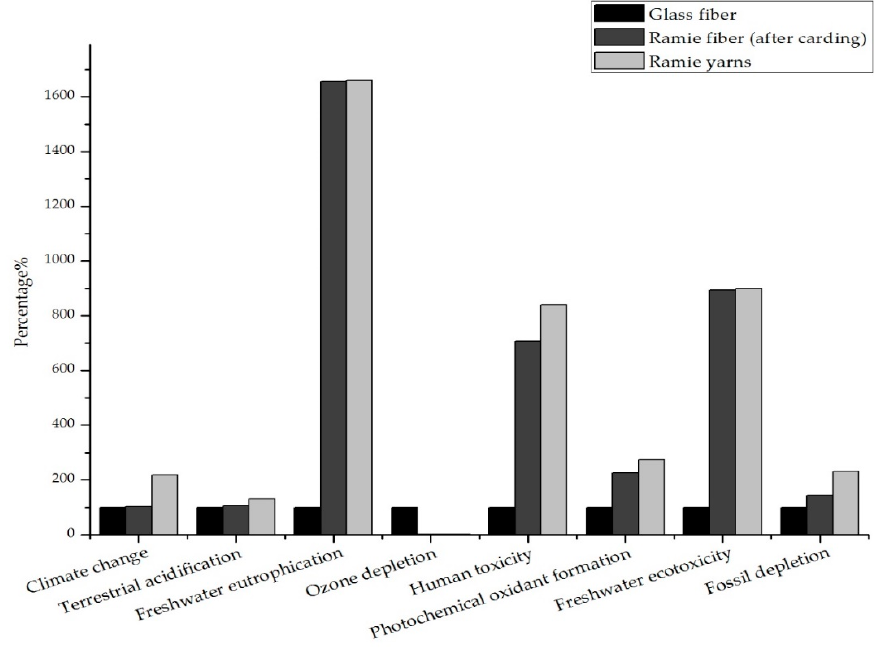
Figure 3. Comparison between three different kinds of fibers in terms of the eight main environmental categories.